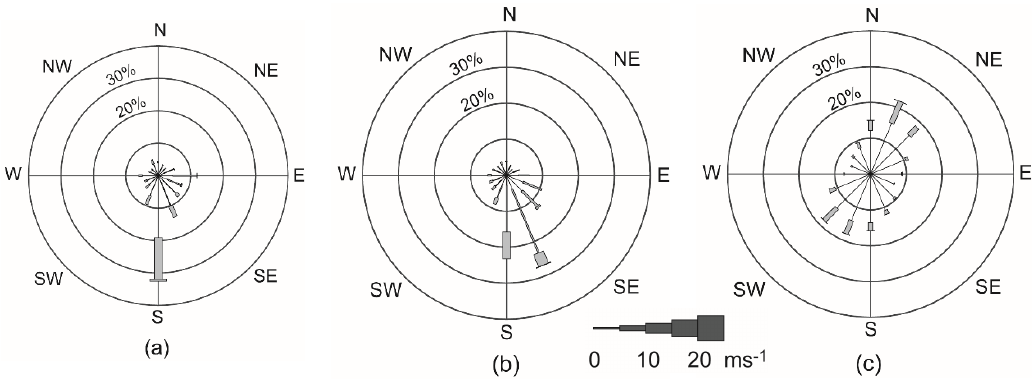
Figure 7. Wind roses for ( a ) original time series; ( b ) low pass time series; and ( c ) high pass time series for the period 22 January to 1 February 2016. Data from the Rottnest Island meteorological station. The wind direction is according to the meteorological